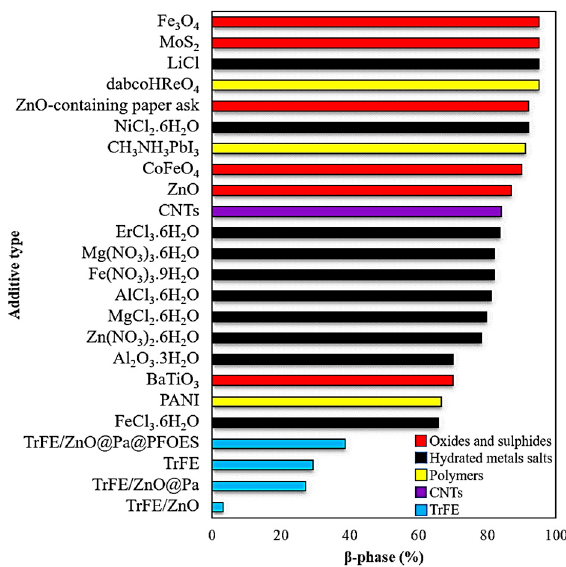
Figure 6. Fraction of β -phase obtained with different additives and copolymers [41,46–54].